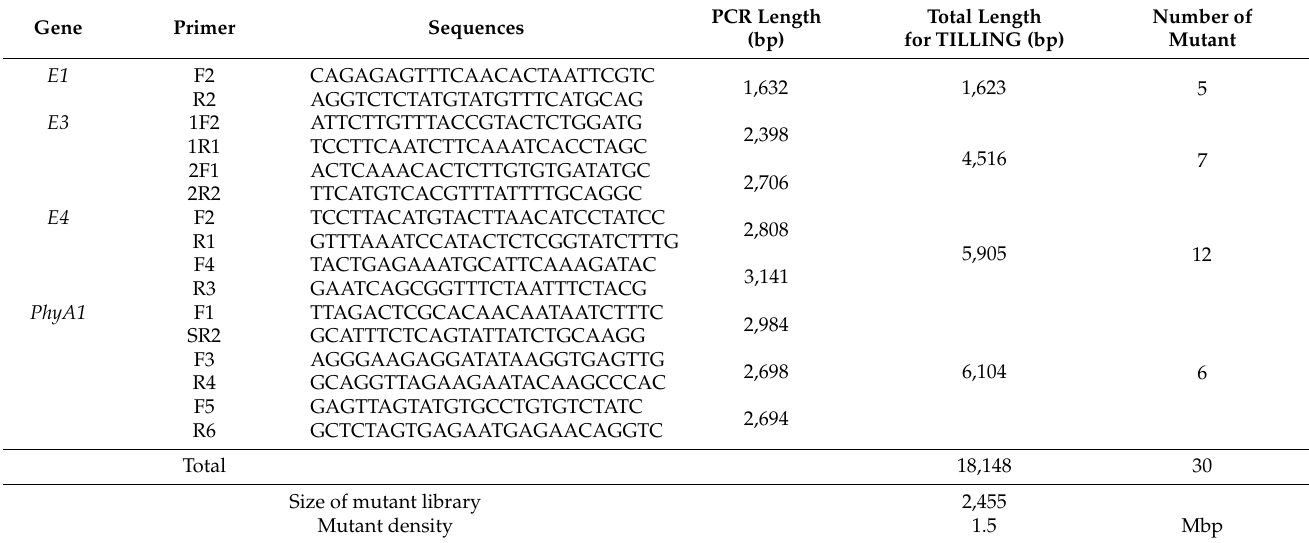
Table 1. Nucleotide sequences of the primers used in this study, mutation density obtained using the TILLING method, and number of individuals in the mutant